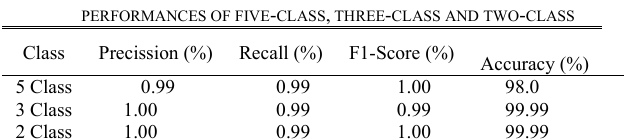
TABLE 7 PERFORMANCES OF FIVE - CLASS , THREE - CLASS AND TWO -